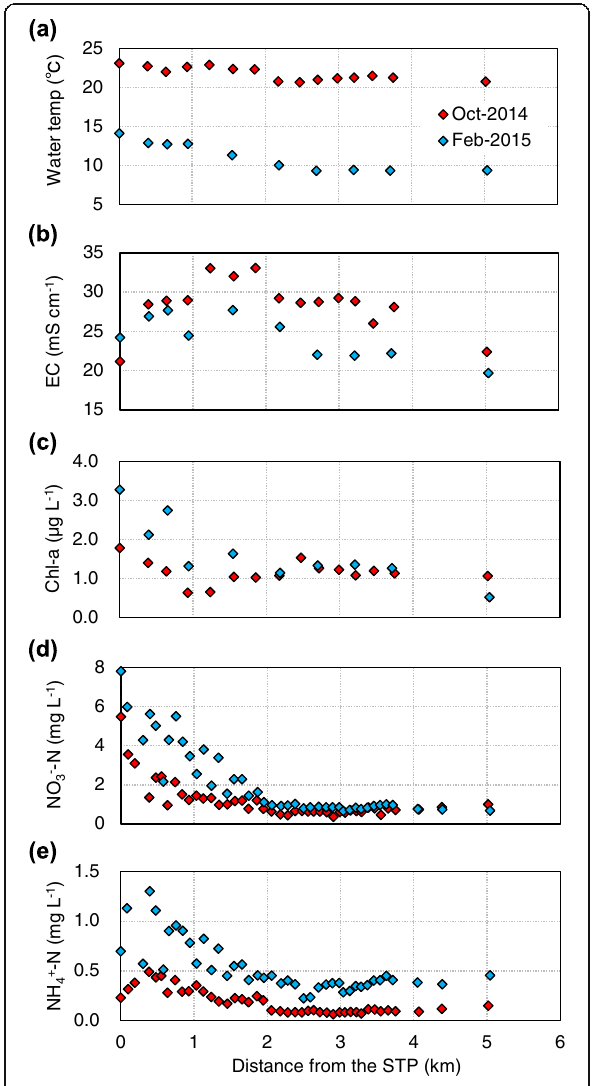
Distance from the STP (km) Fig. 3 Spatial variation of a water temperature, b EC, c Chl-a, d NO 3 − -N, and e NH 4 + -N in the surface seawater on the KH line in October